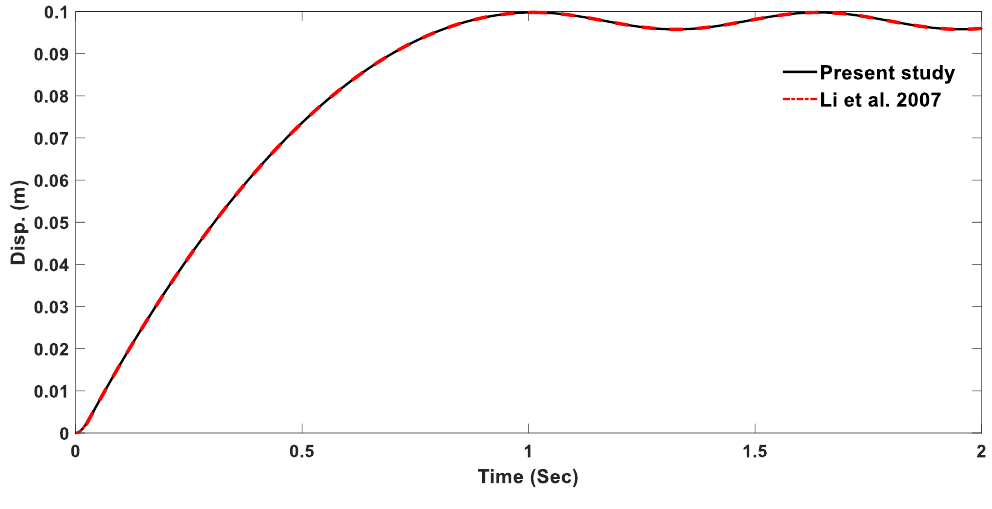
Figure 4. Validation employing study by Li et al. [41].